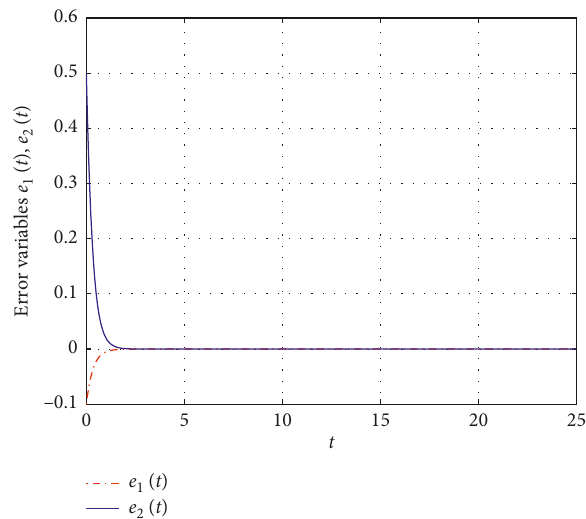
Figure 4: The simulation result for the error system with k